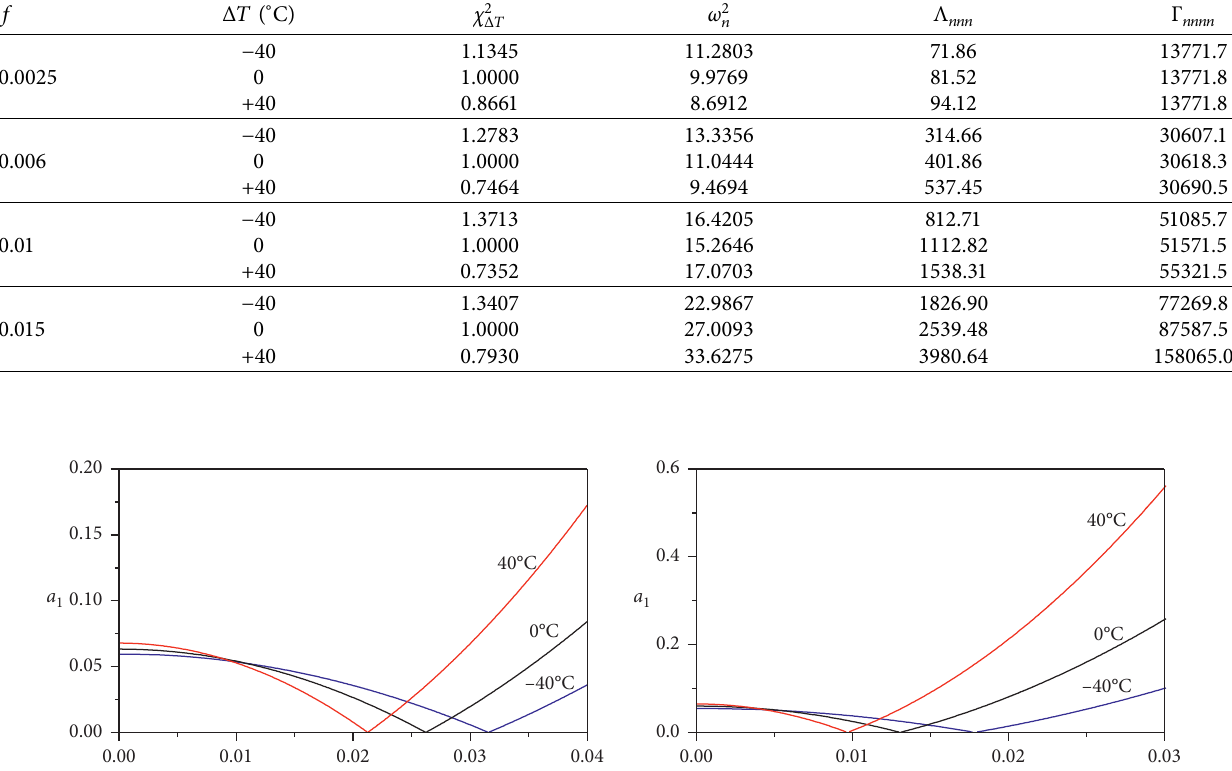
Table 2: Values of corresponding parameters for the first symmetric mode.